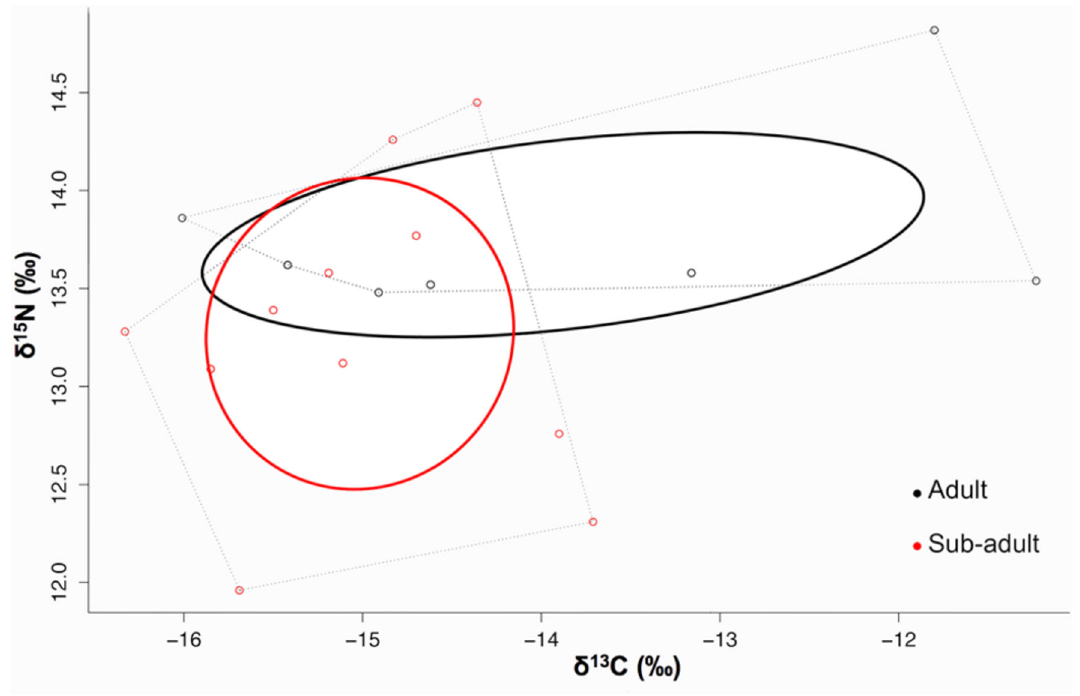
Figure 5. A dual isotope plot representing the niche widths of adult (black line) and sub-adult (red line) bull sharks. Calculated niche width is represented by the small sample size corrected ellipses (solid lines) and displayed in a δ 13 C-δ 15 N niche